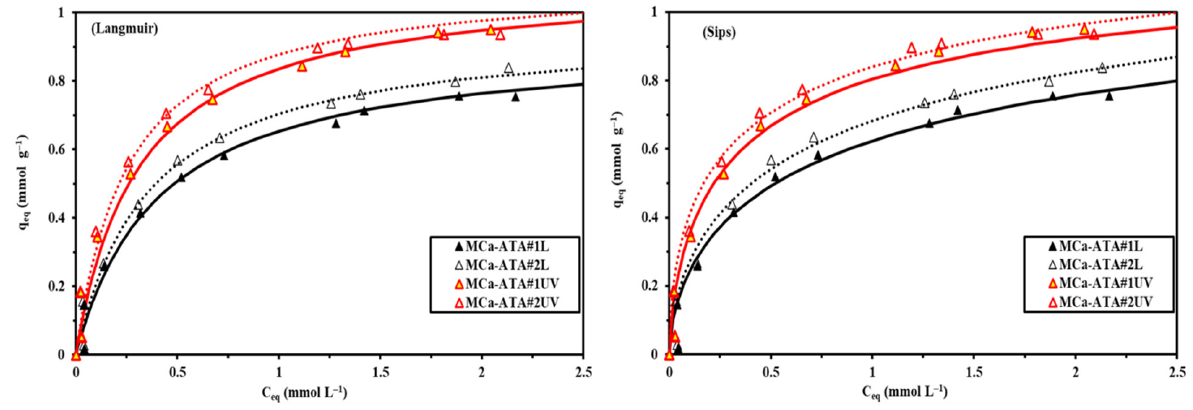
Figure 8. Sorption isotherms (Langmuir and Sips) model of the MCa-ATA sorbent under visible light and UV. Table 3. Parameters of the sorption isotherms for MCc and MCa-ATA under visible light (L) and UV